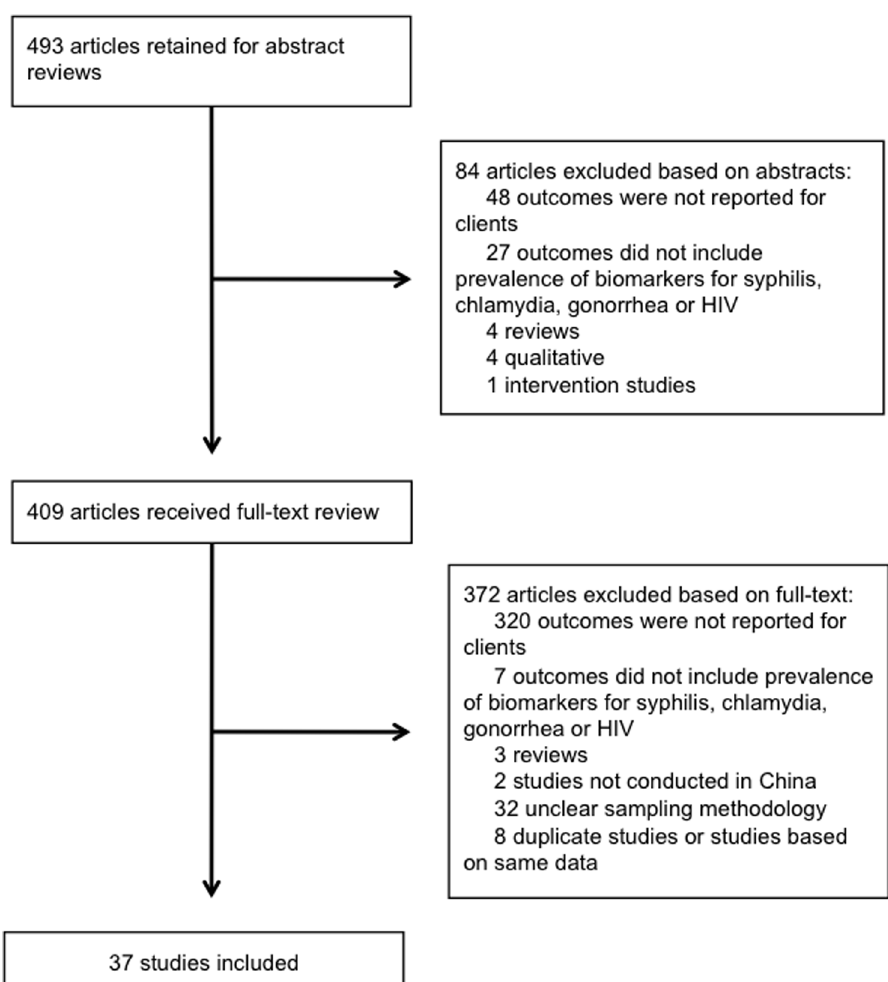
Figure 1. Summary of literature search and study selection.